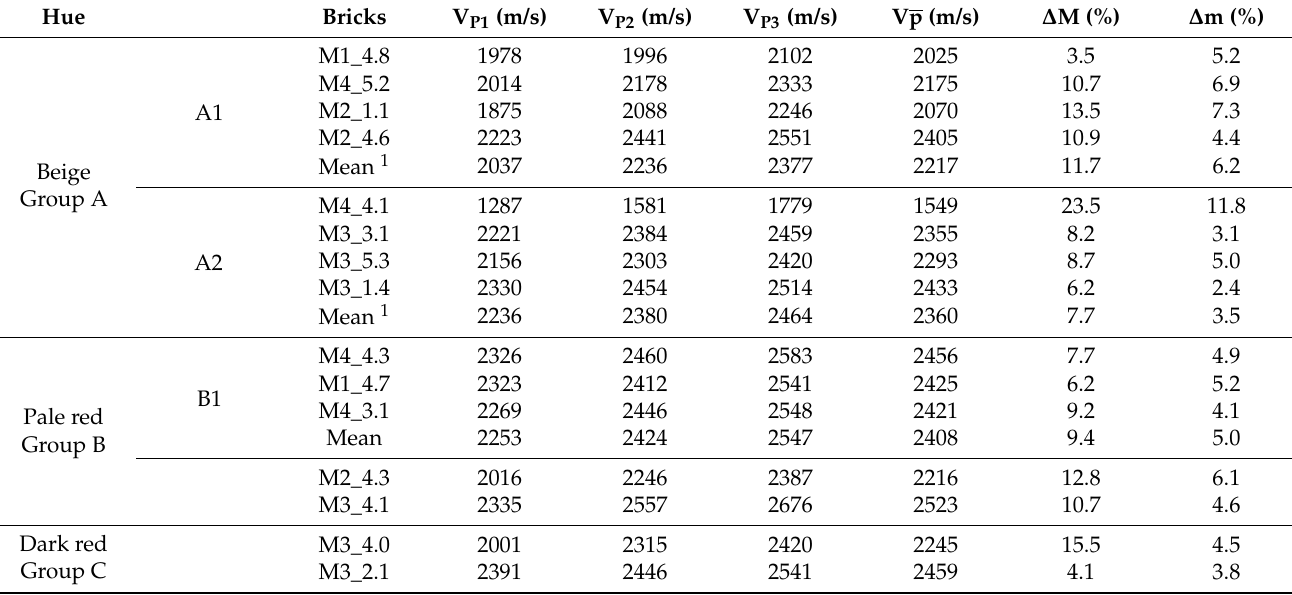
Figure 11. Mercury intrusion porosimetry curves, accumulative (in red) and pore-size distribution (blue) of the beige, pale red and dark red hue ceramic bodies, expressed as volume intrusion of mercury, versus pore radius (in micrometers). Table 4. V P1 , V P2 and V P3 = velocities of ultrasonic wave propagation in the three orthogonal directions (m/s), Vp = mean velocity (m/s), structural ( ∆ M) and relative ( ∆ m) anisotropies (%) of the bricks. Mean values for the petro-fabric are also